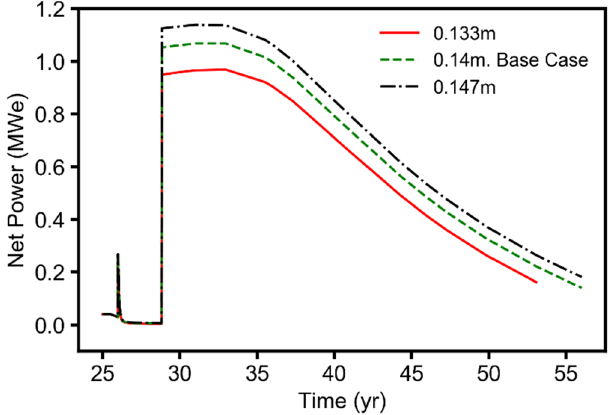
Figure A7. Simulation results (time-series plots) for the mean ambient surface temperature parameter, showing the geothermal net power generated during the EGR and CPG stages (25–55 years).